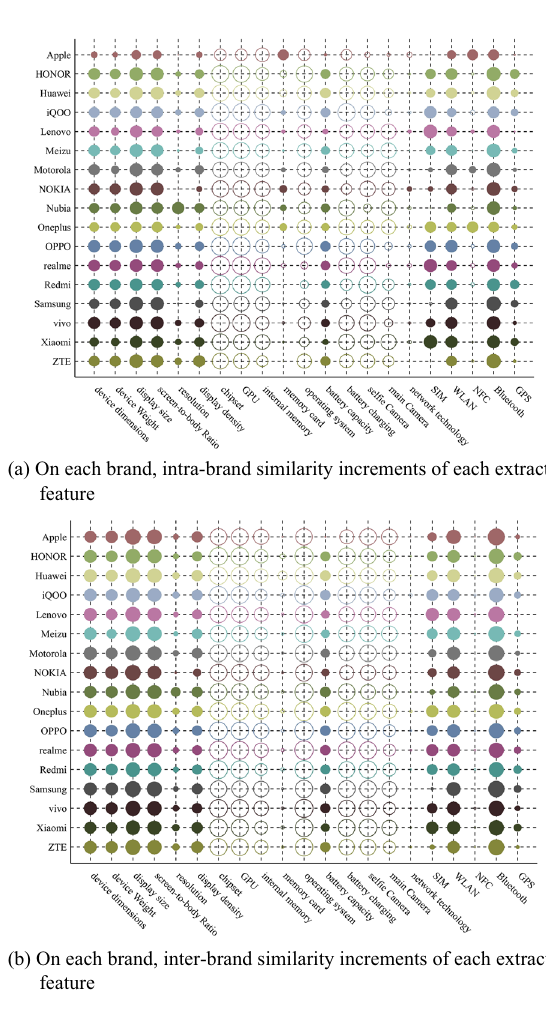
Figure 2. The effect of each extracted feature on the similarity of the devices with same brand and different brands. The size of circle presents absolute value of similarity increment. The bigger the circle is, the larger the value is. The solid circle indicates a positive value, and the hollow circle indicates a negative